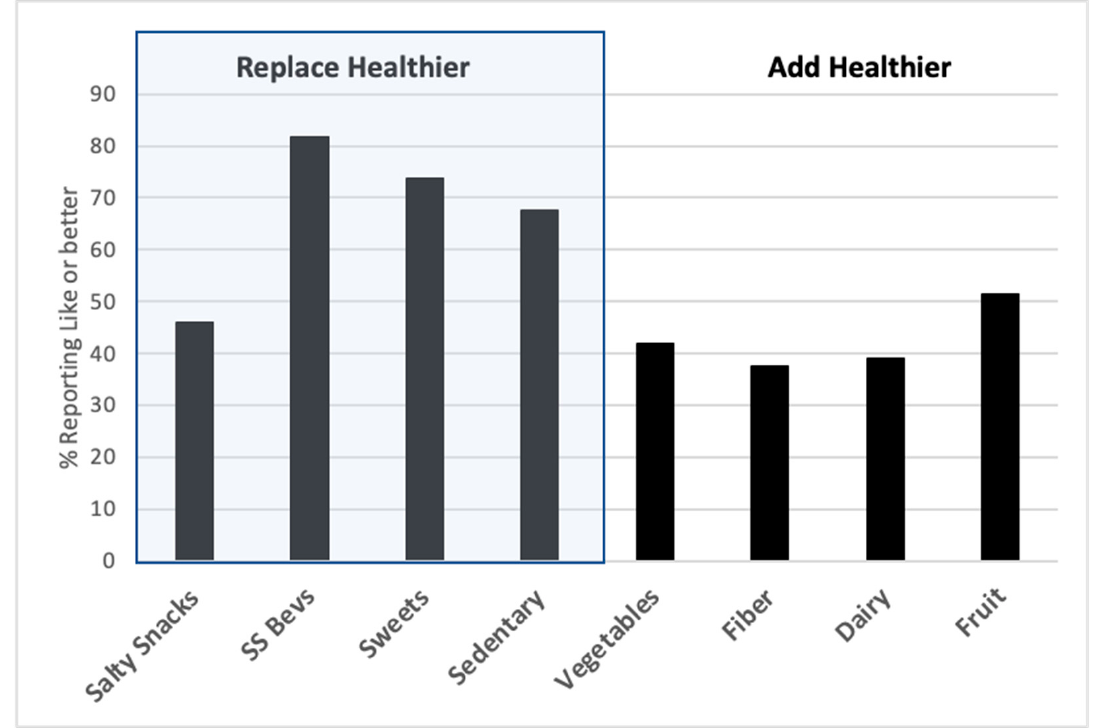
Figure 3. Percentage of students in School A and B who received at least one motivating message reported ≥ “like it” to try the target behavior of the message and more students were willing to replace a less healthy item with a healthier item than to add the healthier item to their diet.